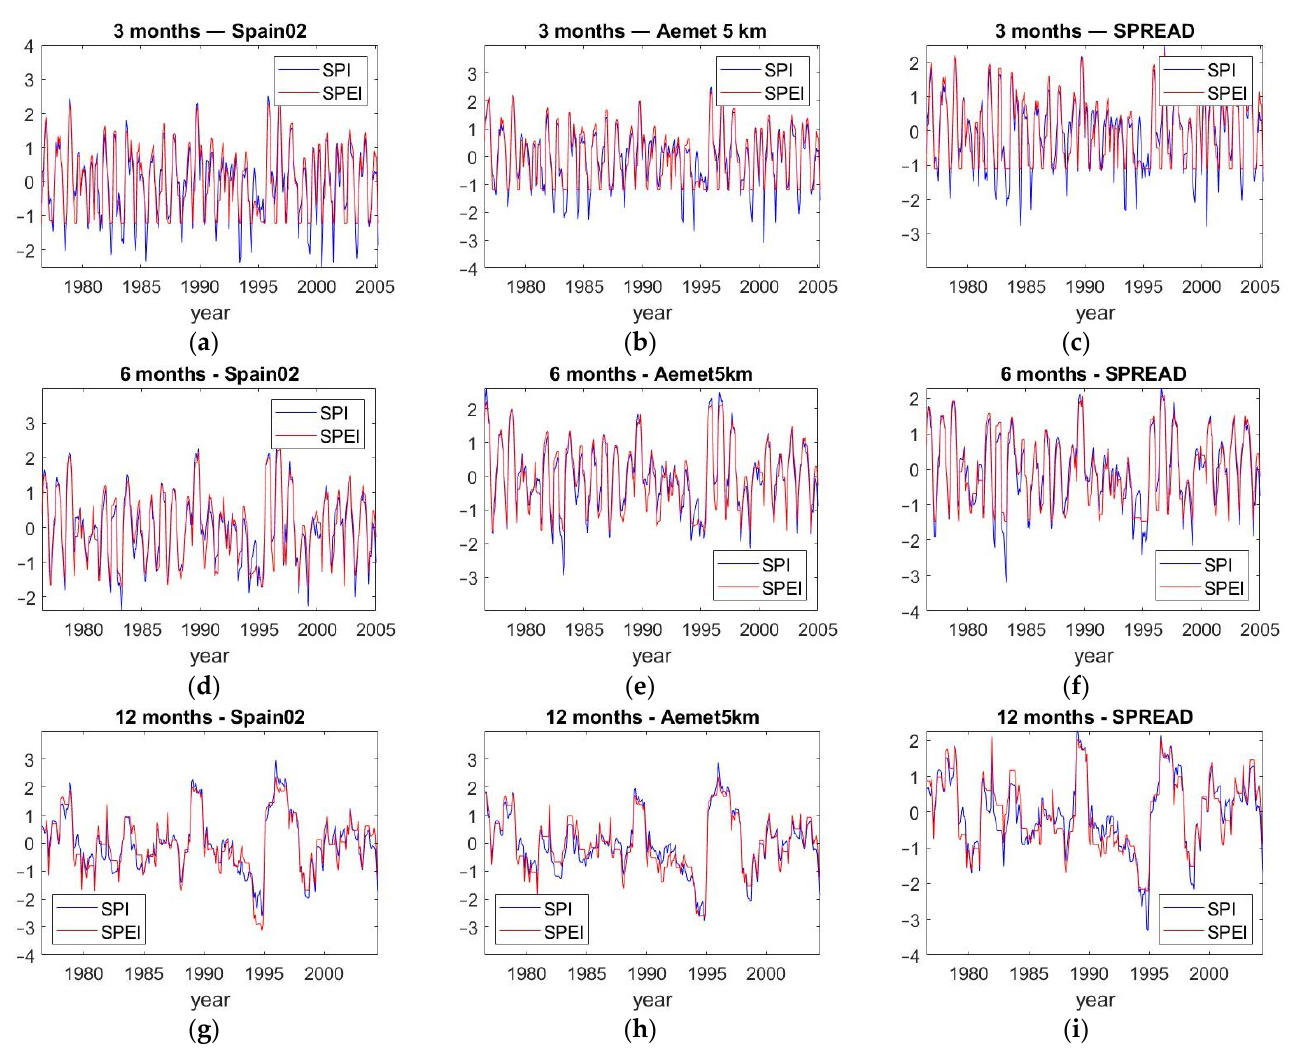
Figure 5. SPI and SPEI temporal evolution for the 3 months temporal-aggregation scale for the ( a ) Spain02 database; ( b ) Aemet 5 km database; ( c ) SPREAD and STEAD database. SPI and SPEI tem- poral evolution for the 6 months temporal-aggregation scale for the ( d ) Spain02 database; ( e ) Aemet 5 km database; ( f ) SPREAD and STEAD database. SPI and SPEI temporal evolution for the 12 months temporal-aggregation scale for the ( g ) Spain02 database; ( h ) Aemet 5 km database; ( i ) SPREAD and STEAD